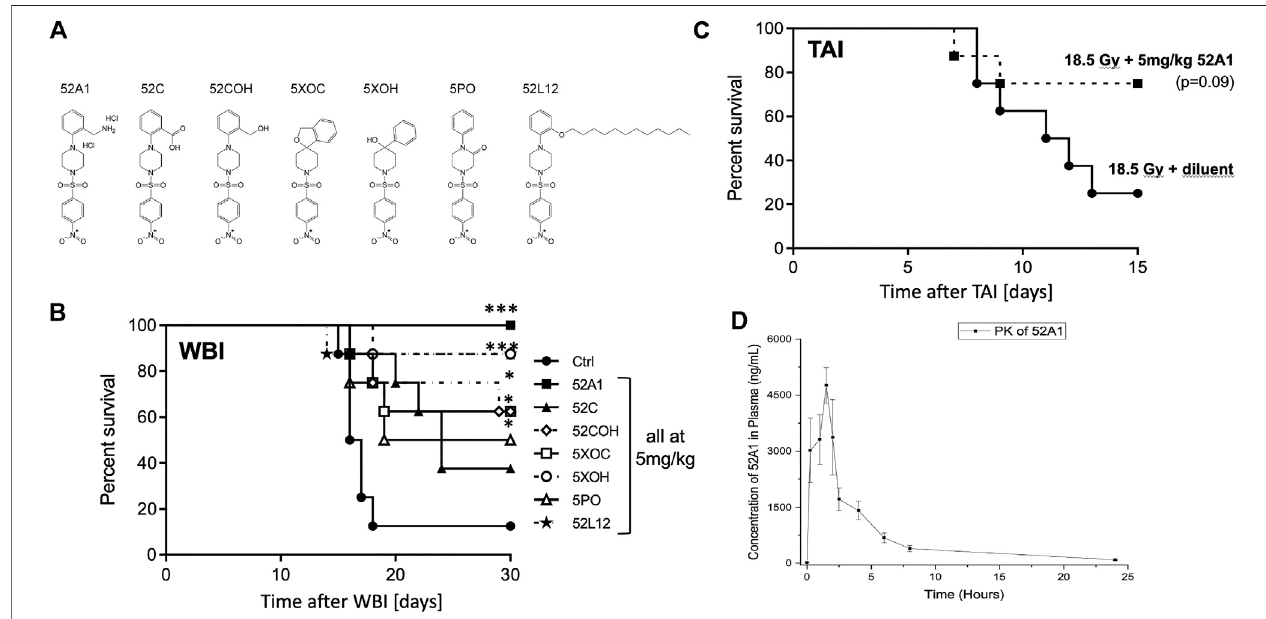
FIGURE4|(A) 512derivativessynthesizedandtestedin (B) amodelofH-ARSusingLD70/30doses(X-rays)inC3Hmice.Drugsweregiven5 × s.c.,exceptforthe lipidated52L12,whichwasgivenbygavageinKollopher EL.Thewatersoluble2-(aminomethyl)-derivativeof512,52A1,wasmosteffective. (C) 52A1alsomitigatedGI- ARS in C57Bl/6 mice given 18.5 Gy WBI with 2.5% body shielding. (D) PK of 52A1 is similar in shape to 512 but the Cmax is almost 40 times higher. * (cid:2) p < 0.05, ** p < 0.01, *** p < 0.001.